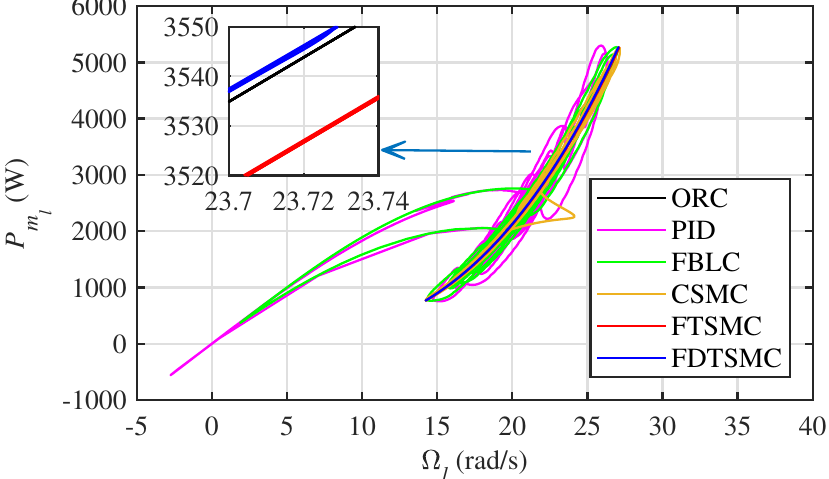
Figure 12. Mechanical power versus the low-speed shaft rotational